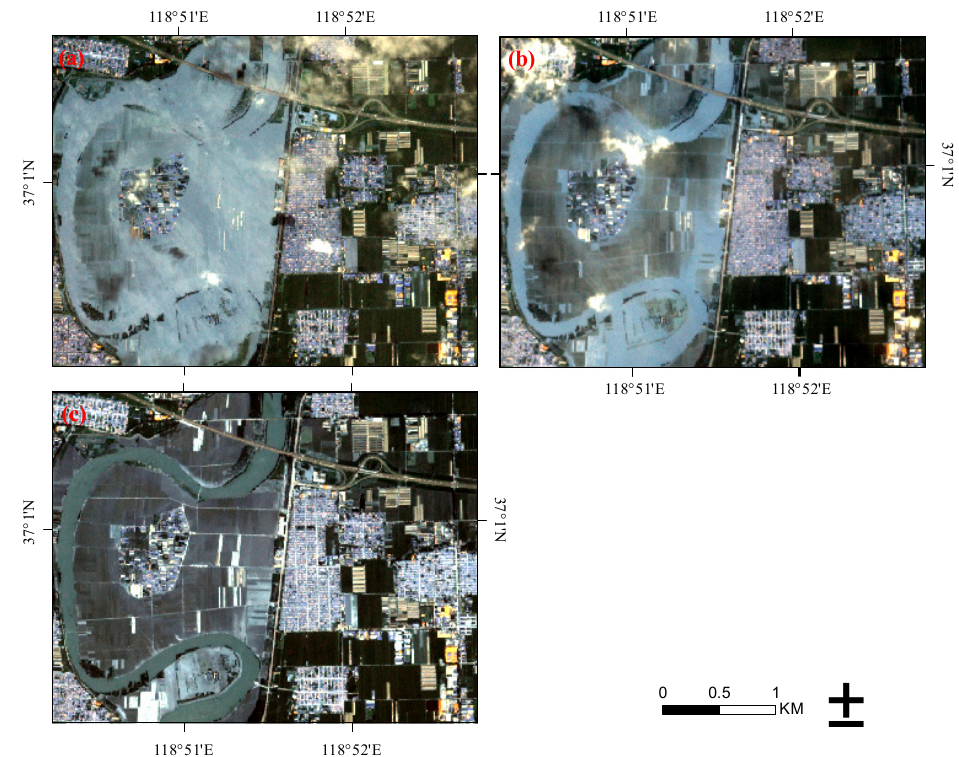
Figure 9. Planet images in the studied area on 20 August 2018 ( a ), 21 August 2018 ( b ) and 27 August 2018 ( c ).